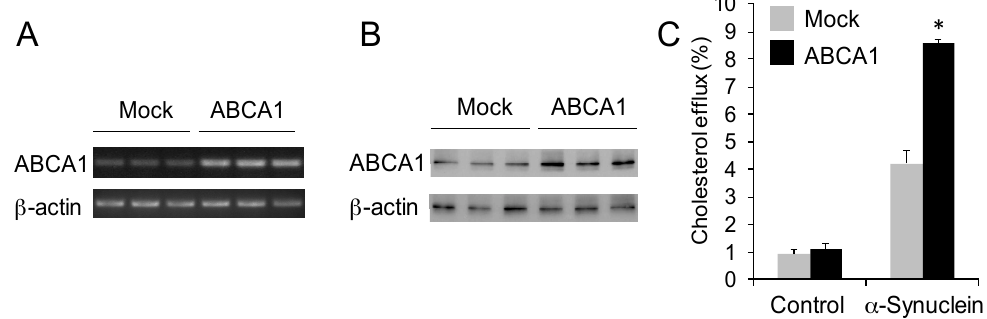
Figure 3. α -Synuclein mediates cholesterol efflux via ABCA1. ( A ) Agarose gel electrophoresis shows an increased expression of ABCA1 in SK-N-SH neuronal cells that were transfected with ABCA1 cDNA compared to cells transfected with empty vector (mock). The housekeeper gene β -actin was used as an internal control; ( B ) Western blotting shows an increased expression of ABCA1 in SK-N-SH neuronal cells that were transfected with ABCA1 cDNA compared to cells transfected with empty vector (mock). The housekeeper gene β -actin was used as an internal control; ( C ) Cholesterol efflux of SK-N-SH neuronal cells transfected with either ABCA1 or mock cDNA and treated with α -synuclein or PBS ( − ve control) for 4 h. Data represent mean ( n = 6) and SE as error bars, * p < 0.0005.